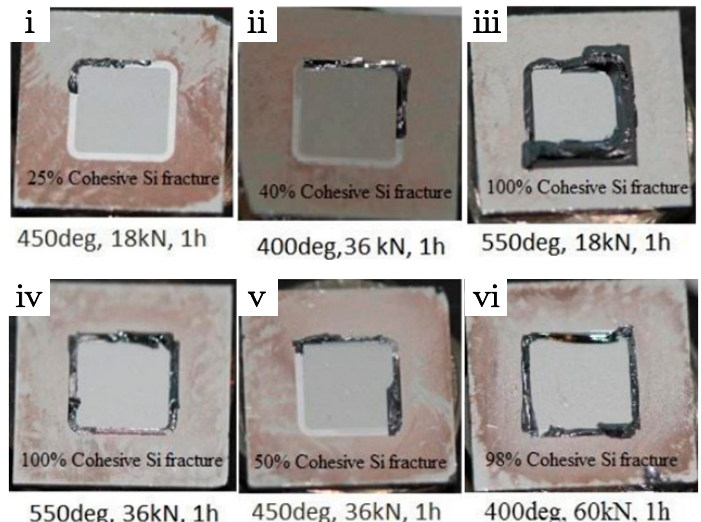
Figure 4. Effect of bonding temperature and pressure influence on Al–Al bonding quality [35].